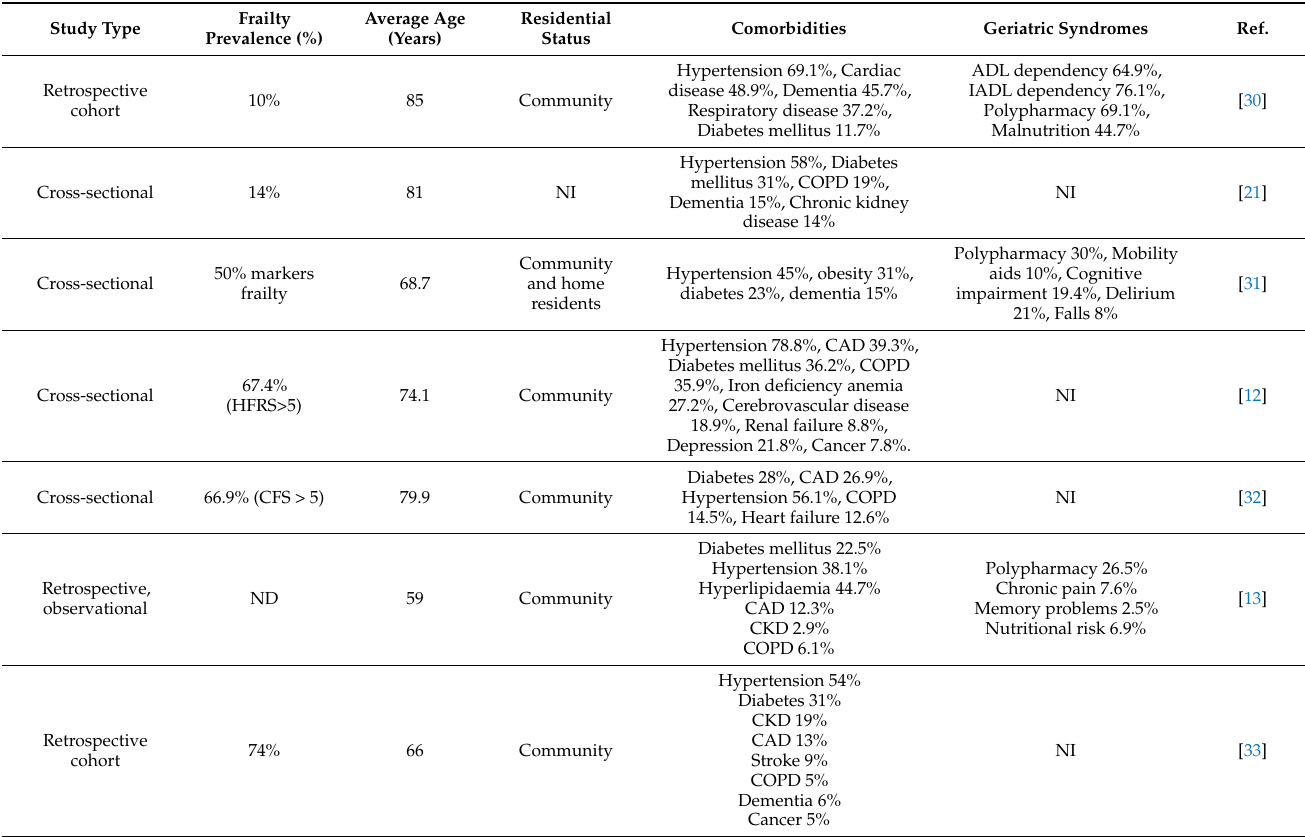
Table 2. Characteristics of geriatric patients with COVID-19 and morbidities